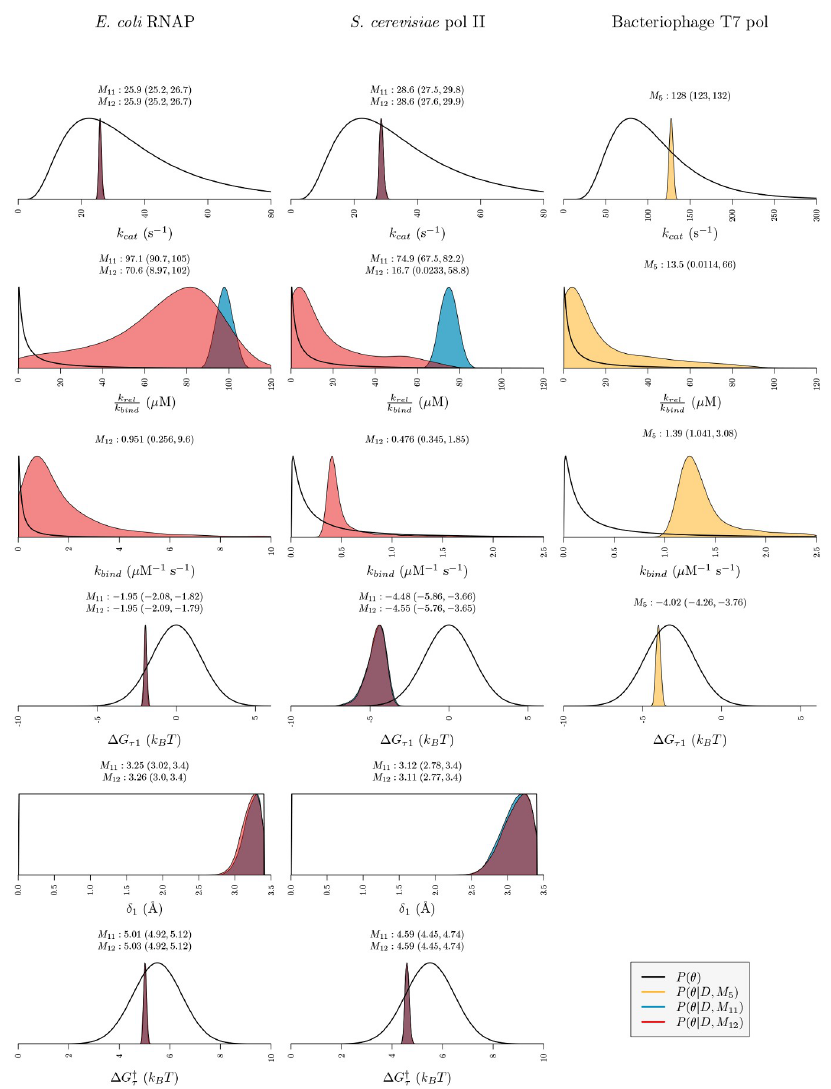
Fig 5. Posterior and prior distribution plots. Posterior distributions for all models which appear in the 95% credible set are displayed (two models for RNAP, two models for pol II, and one model for T7 pol). Plots show the prior probability density P ( θ ) of each parameter and posterior probability density of each parameter conditional on the model P ( θ | D , M i ). The geometric median point-estimates and highest posterior density (HPD) intervals (calculated with Tracer 1.6 [53]) are displayed above each plot (3